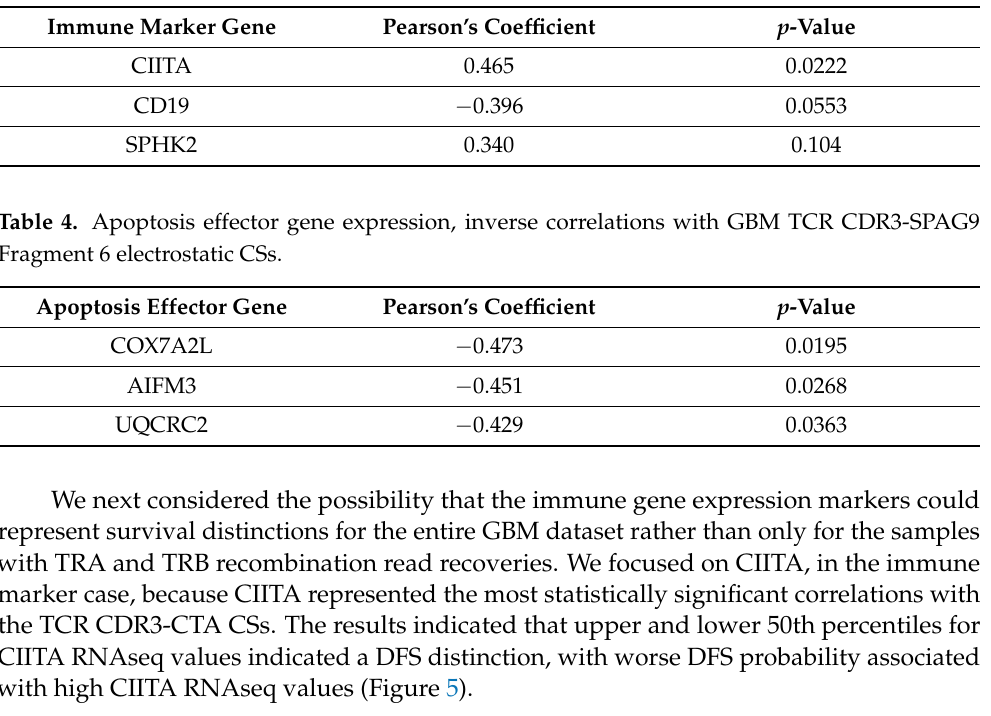
Figure 4. KM analysis comparing DFS for case IDs representing the upper and lower 50th percentile for the TCR CDR3-SPAG9 Fragment 6 electrostatic CSs. ( A ) The case IDs represent the upper 50th percentile electrostatic CS group (black line, n = 21) and lower 50th percentile electrostatic CS group (grey line, n = 23). ( B , C ) Scatter plots showing a correlation of the expression of SPHK2 and CIITA genes and electrostatic CSs for the TCR CDR3-SPAG9 Fragment 6. See also Table 3; Table S7. Table 3. Immune marker gene expression correlations with GBM TCR CDR3-SPAG9 Fragment 6 electrostatic CSs.